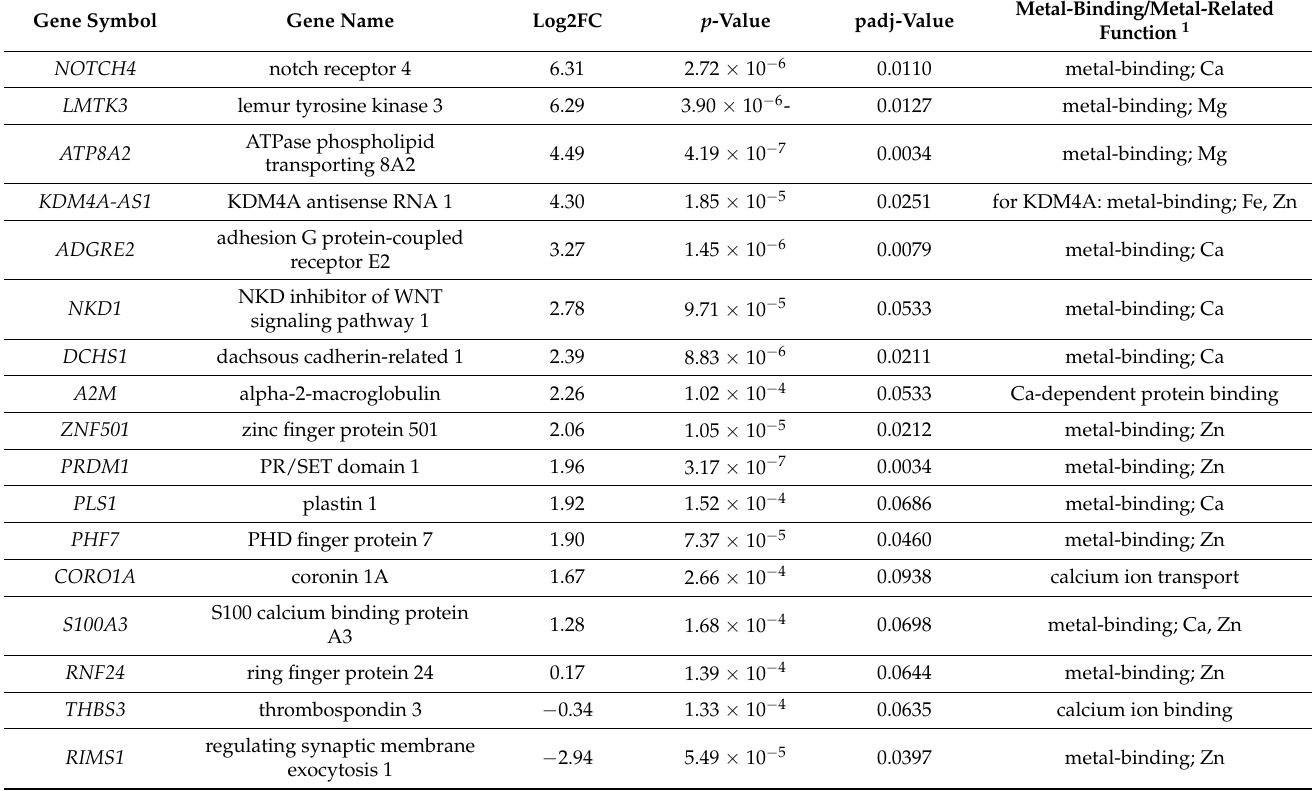
Figure 1. Transcriptomic metal-related gene alterations in AD) and MCI olfactory mucosa (OM) cells. The volcano plot visualizes the differentially expressed genes (DEGs) between the OM cells derived from cognitively healthy controls and patients with ( a ) Alzheimer’s disease (AD) or ( b ) mild cognitive impairment (MCI). The significant DEGs upregulated in AD OM cells are visualized in red (positive fold change) and the significantly downregulated DEGs in blue (negative fold change). The metal-related DEGs are highlighted. Table 1. Differentially expressed genes (DEGs) with metal-ion binding abilities or other metal-related function between the Alzheimer’s disease (AD) and control olfactory mucosa (OM) cells identified by total RNA sequencing. FC, fold change. padj-value (adjusted p -value, false discovery rate) < 0.1.